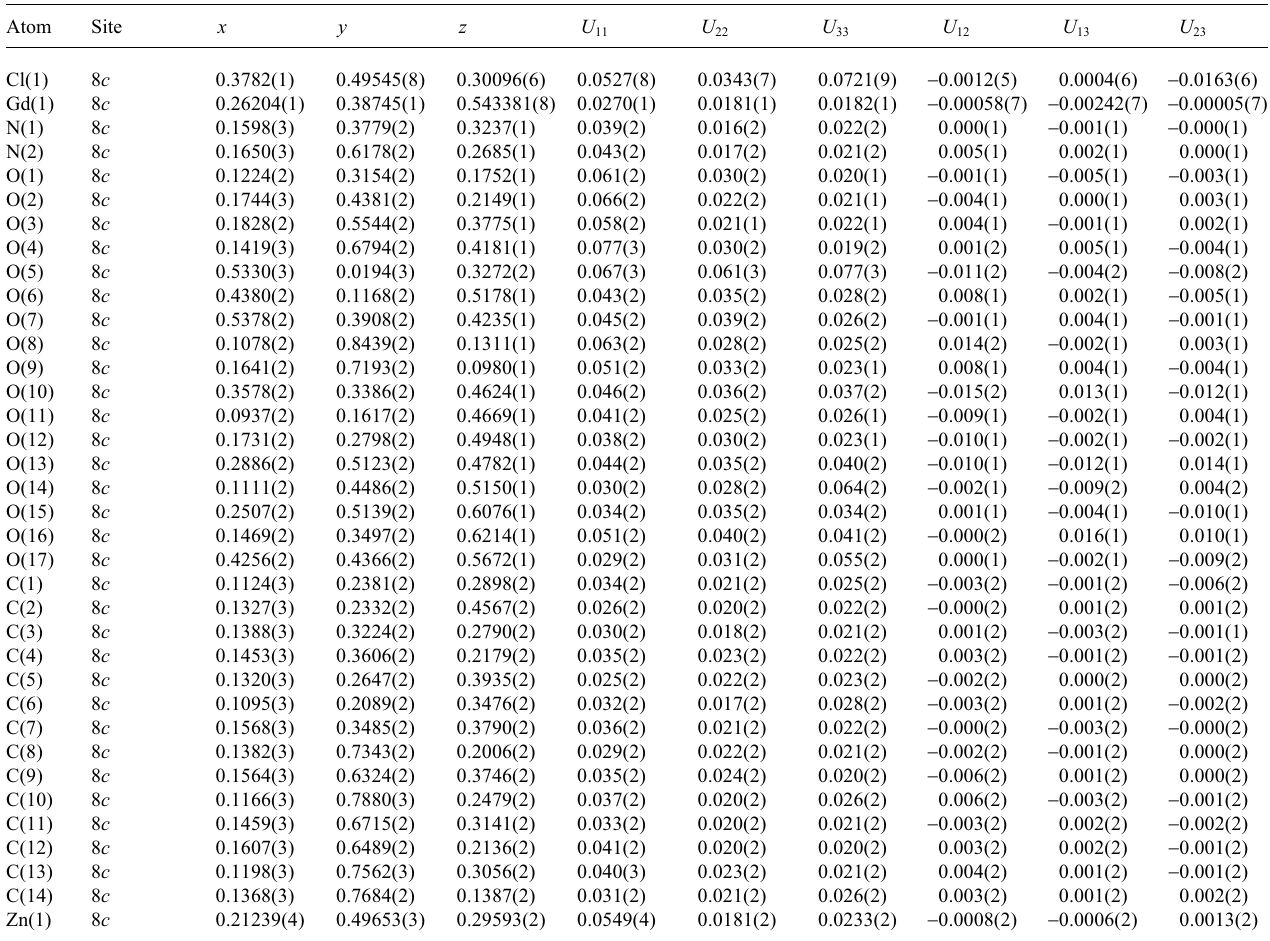
Table 3. Atomic coordinates and displacement parameters (in Å 2